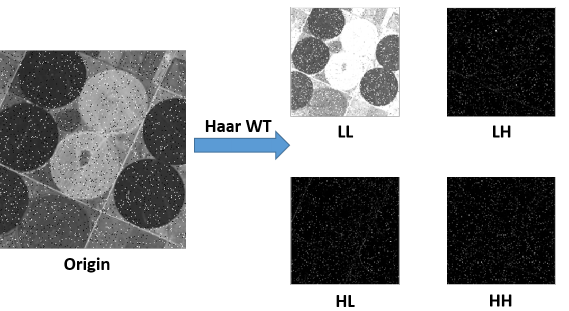
Figure 15. Wavelet transform schematic diagram of image with salt and pepper